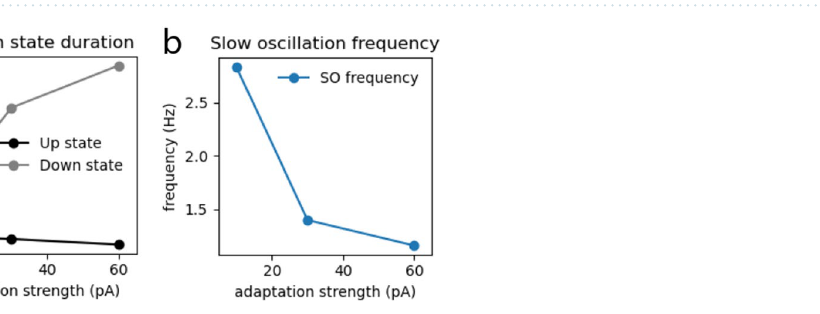
Figure 5. LFP-NPL correlation measures. a-c. Median values of the Pearson’s correlation, Peak cross- correlation and Delay to the cross-correlation peak across n=67 recordings (8 mice). d-f. Same correlation measures plotted across different levels of anesthesia.